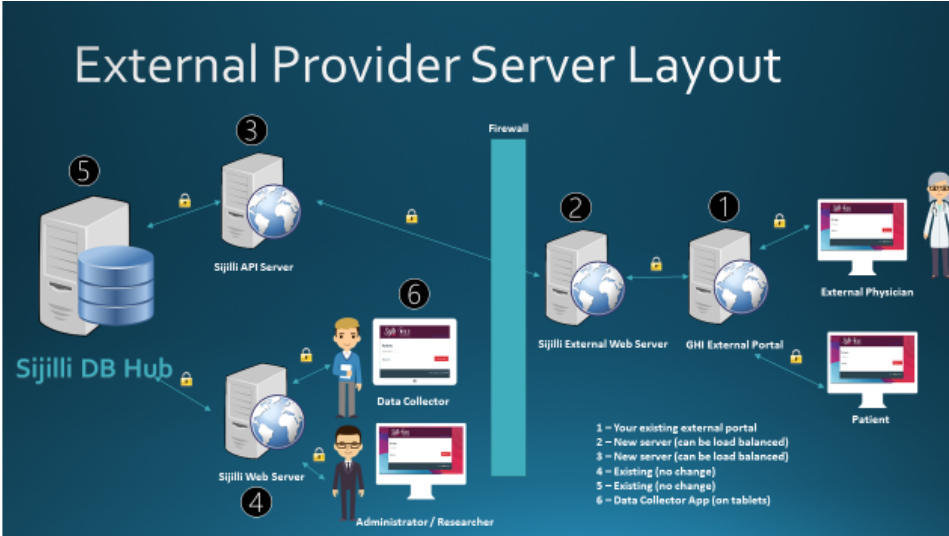
Figure 2. Architecture diagram of the Sijilli electronic health record. API: application programming interface; DB: database; GHI: Global Health